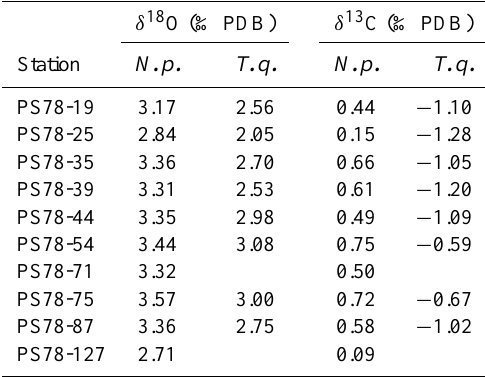
Figure 8. δ 18 O and δ 13 C of N. pachyderma (circles) and T. quinqueloba (squares) from the water column (weighted average over the upper 500m of the water column; non-filled symbols) and from the sediment surface (filled symbols) along a transect at 78 ◦ 50 (cid:48) N across the Fram Strait. Table 3. δ 18 O and δ 13 C values of N. pachyderma ( N. p. ) and T. quinqueloba ( T. q. ) from sediment surface